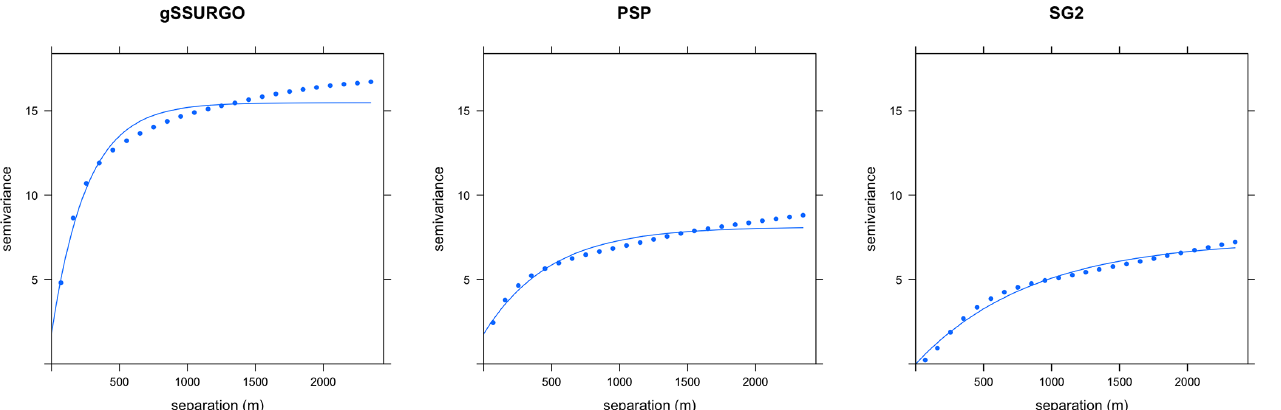
Figure 24. Fitted variograms for pH at 0–5cm. The semivariance units are (pH × 10) 2 . Note the short range of gSSURGO and the low sill of SG2 and